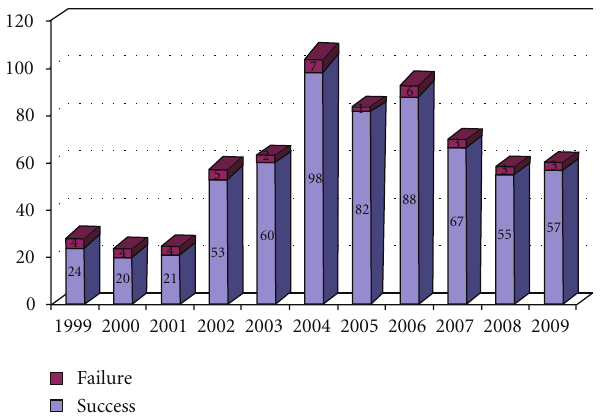
Figure 1: Annual number of cases of transcatheter closure of ASD and failure ratios, Siriraj Hospital ( n =